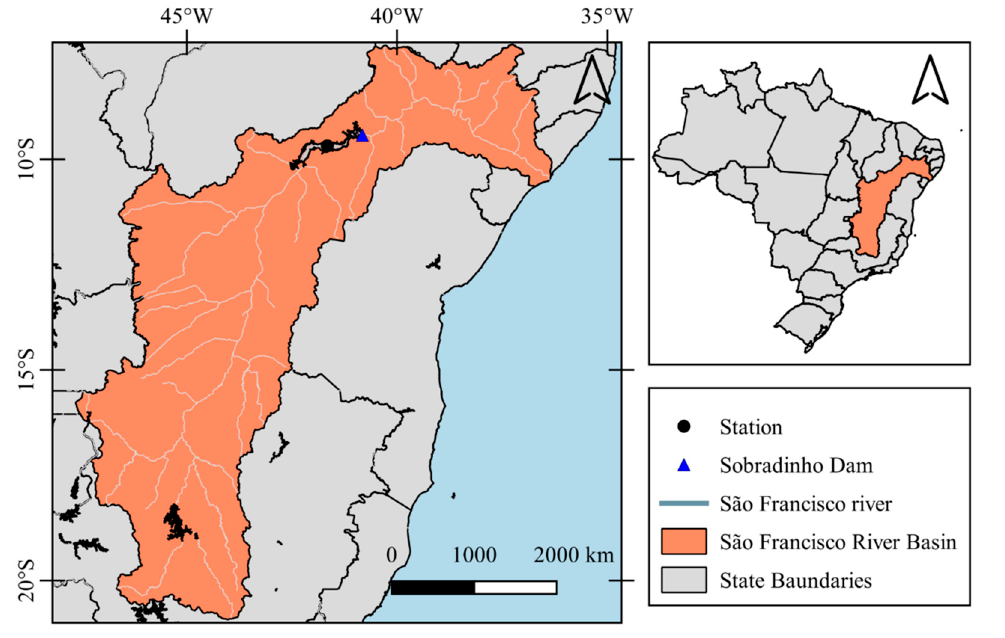
Figure 1. Location of the Sobradinho Reservoir, Brazil .